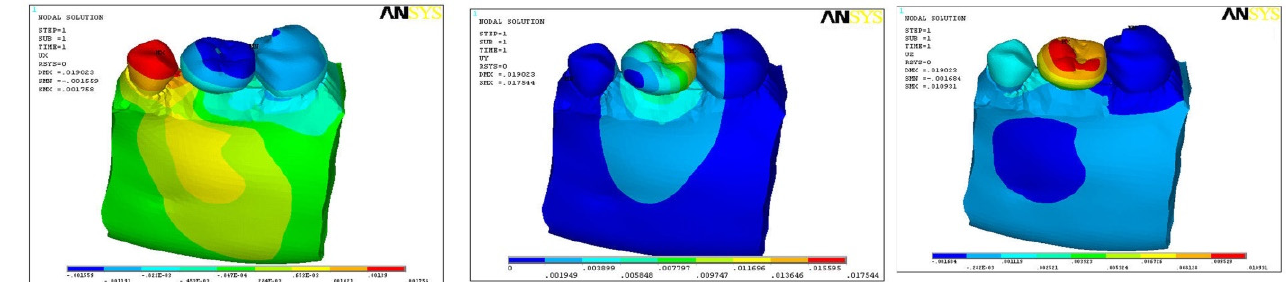
Figure 7. Direction of force in model B3.